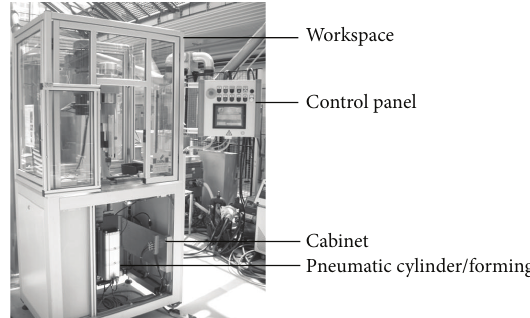
Figure 10: Joining device for manufacturing heavy duty hybrid joints.